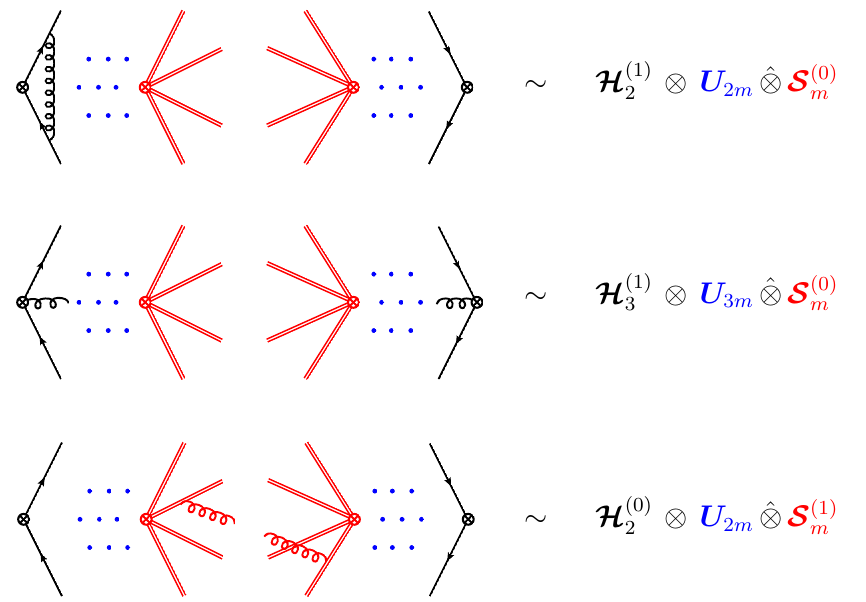
Figure 2 . Pictorial representations of the di(cid:11)erent ingredients for LL 0 resummation of the interjet energy (cid:13)ow. The diagrams on the three lines correspond to the one-loop corrections from H (1) H (1) and S (1) , respectively. The virtual corrections to S m are scaleless and m 3